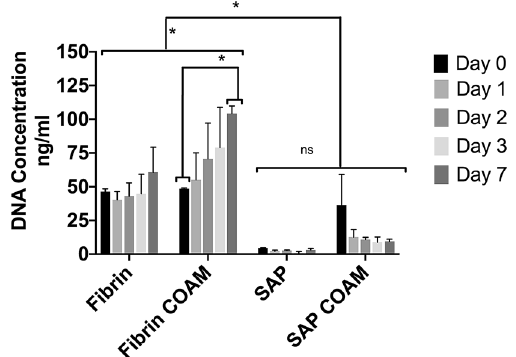
Figure 5. DNA content of cell-laden hydrogels: results are presented as mean ± SEM, ns refers to not significant, *significant